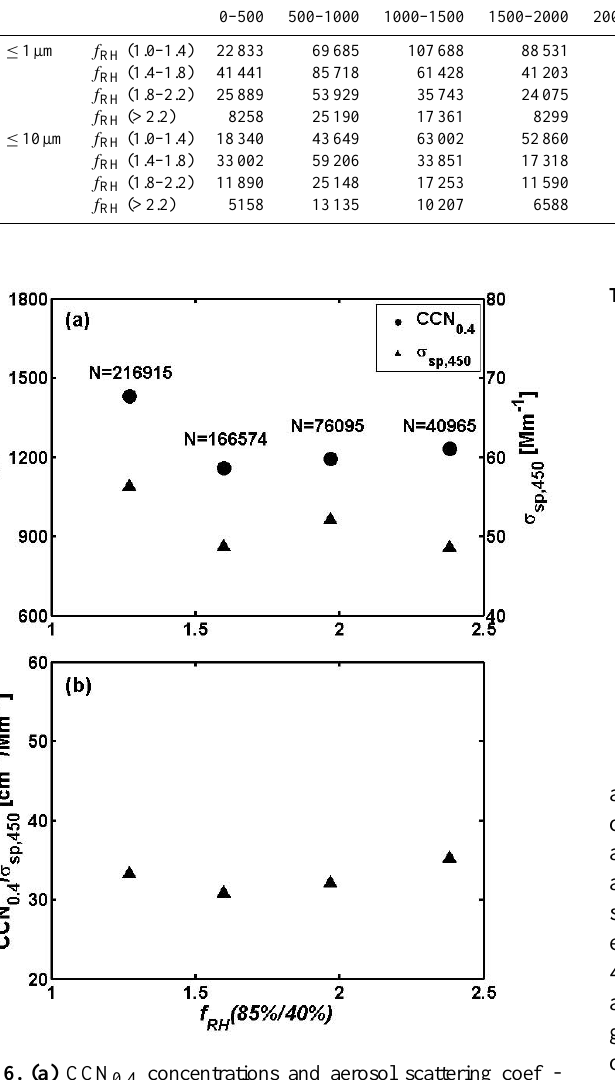
for small particles, which are not optically sensitive but are f RH -sensitive.